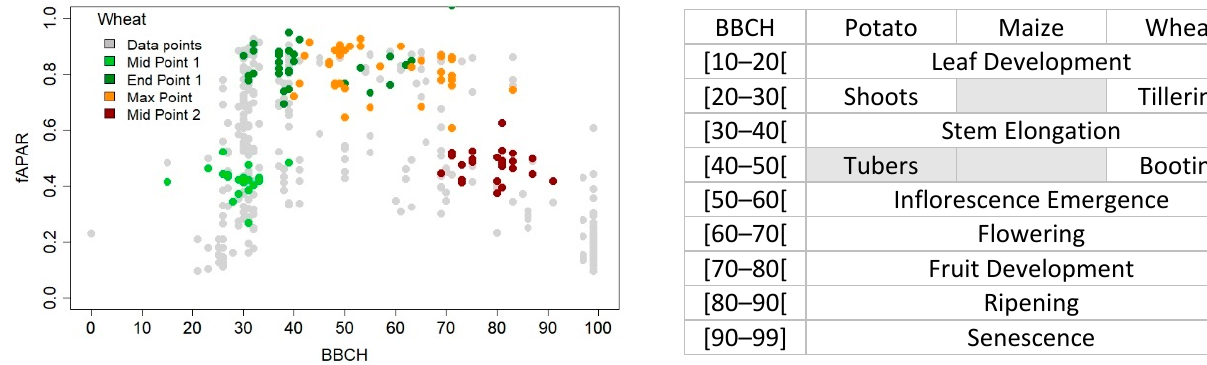
Figure 14. BBCH codes and mathematically derived model points of Sentinel-2 fAPAR for all maize, potato, and wheat fields during 2016–2017.